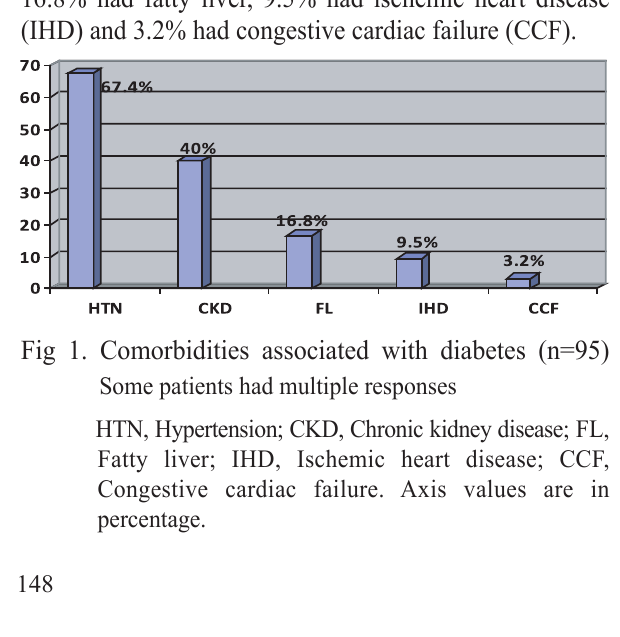
Table IV: Factors precipitating hypokalemia